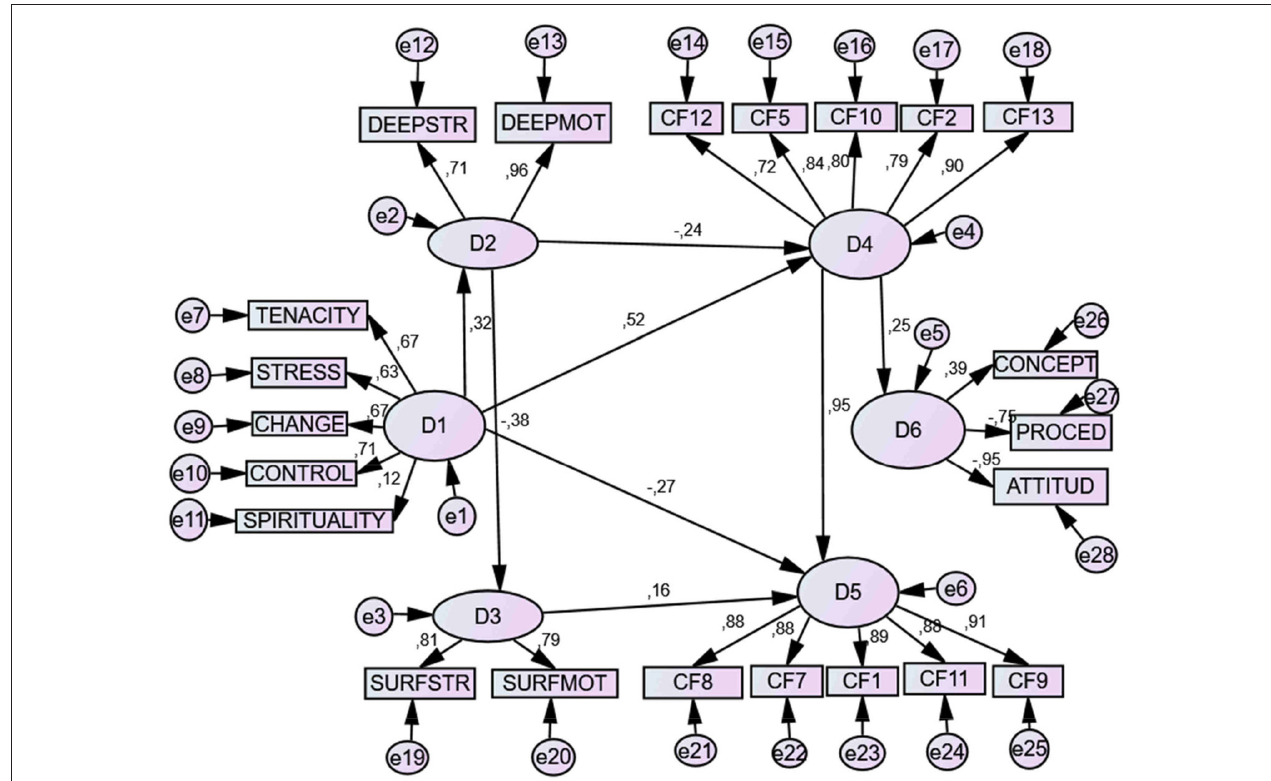
FIGURE 1 | Structural model of relations proposed between Resilience (D1), Deep approach (D2), Surface approach (D3), Coping strategies centred on the problem (D4), Coping strategies centred in emotion (D5), and academic achievement (D6). TENACITY, Tenacity; ESTRES, Tolerance to stress; CHANGE, Change; CONTROL, Perception of control; SPIRITUALITY, Spirituality; D2, Deep approach; DEEPSTR, Deep strategy; DEEPMOT, Deep motivation; SURFSTR, Surface strategies; SURFMOT, Surface motivation; CF12, Communication of feelings and social support; CF5, Self-instructions; CF10, Positive re-evaluation and firmness; CF2, Search for help and family advice familiar; CF13, Search for alternative reinforcement CF8, Preparing for the worst; CF7, Reduction of anxiety and avoidance; CF1, Evasive distraction; CF11, Resigned acceptance; CF9, Emotional discharge and isolation. CONCEPT, Conceptual achievement; PROCED, Procedural achievement; ATT, Attitudinal